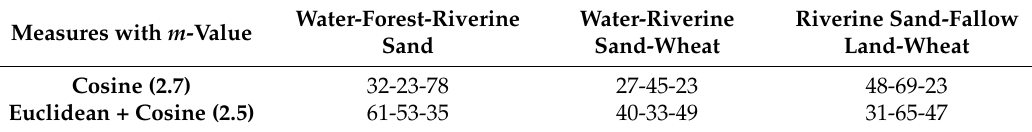
Table 7. The comparative results of the best single similarity measures and the composite measure while handling the mixed pixel containing three classes (membership value was calculated on 8-bit scale i.e., the target values for each class were 76.5, 76.5, 102,